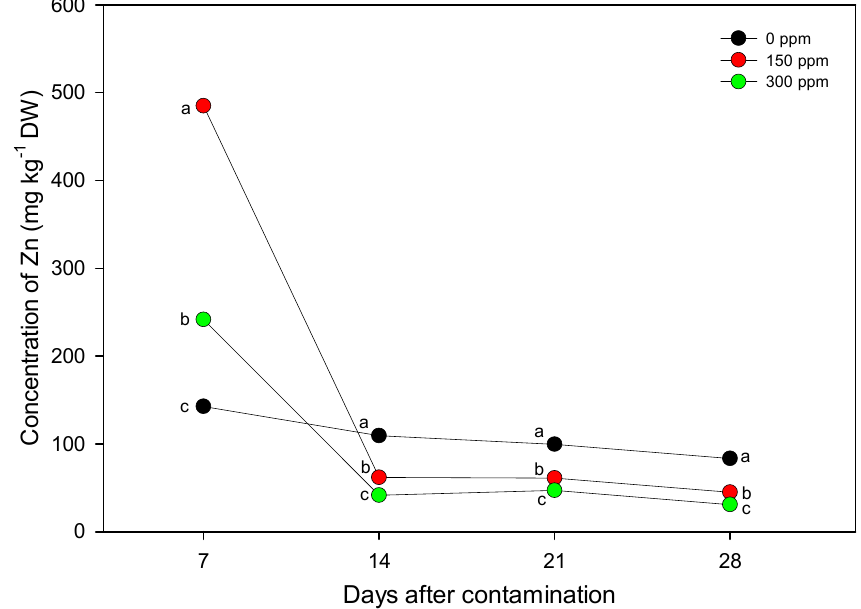
Figure 8. Time course of the zinc concentration in the leaves of Arundo plants treated with different copper concentrations (0, 150, and 300 ppm) for 28 days. Data points and vertical bars represent means (n = 3) ± S.E., respectively (when not reported S.E. is smaller than symbol size). One-way ANOVA was applied and for a given duration different letters indicate significant difference according to Tukey test ( p ≤ 0.01).